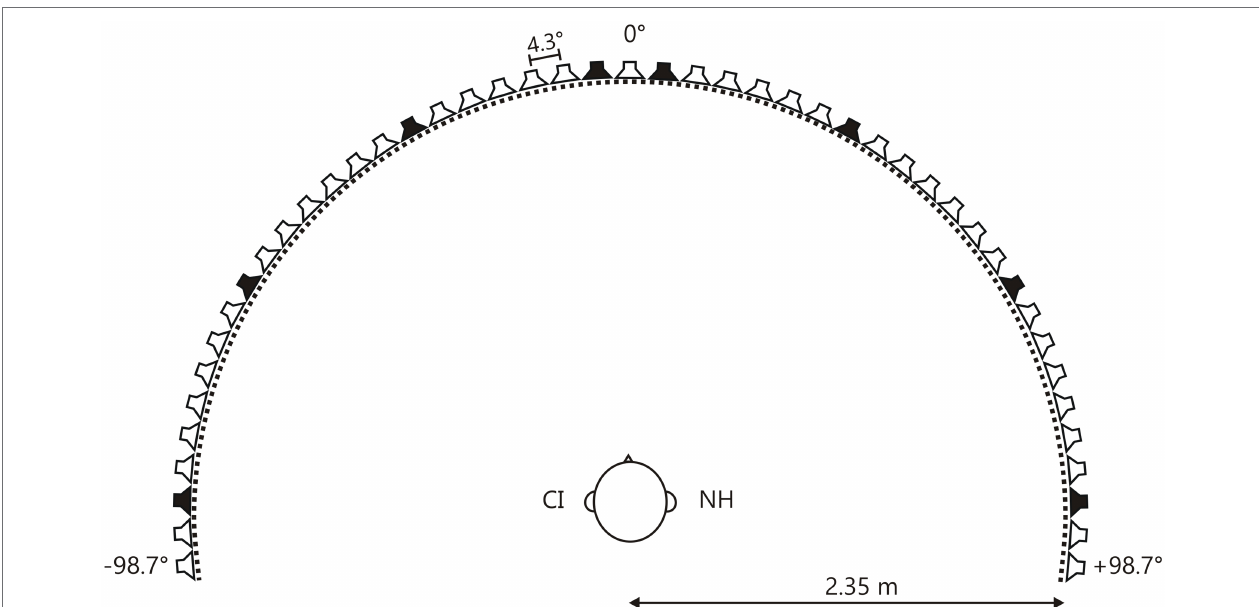
FIGURE 1 | Loudspeaker array. Forty-seven speakers placed on a semicircular array with a radius of 2.35 m. The separation between speakers was 4.3 ° . The head of the participant was directed toward 0 ° . Test locations were ±4 ° , ±30 ° , ±60 ° , and ±90 ° (black